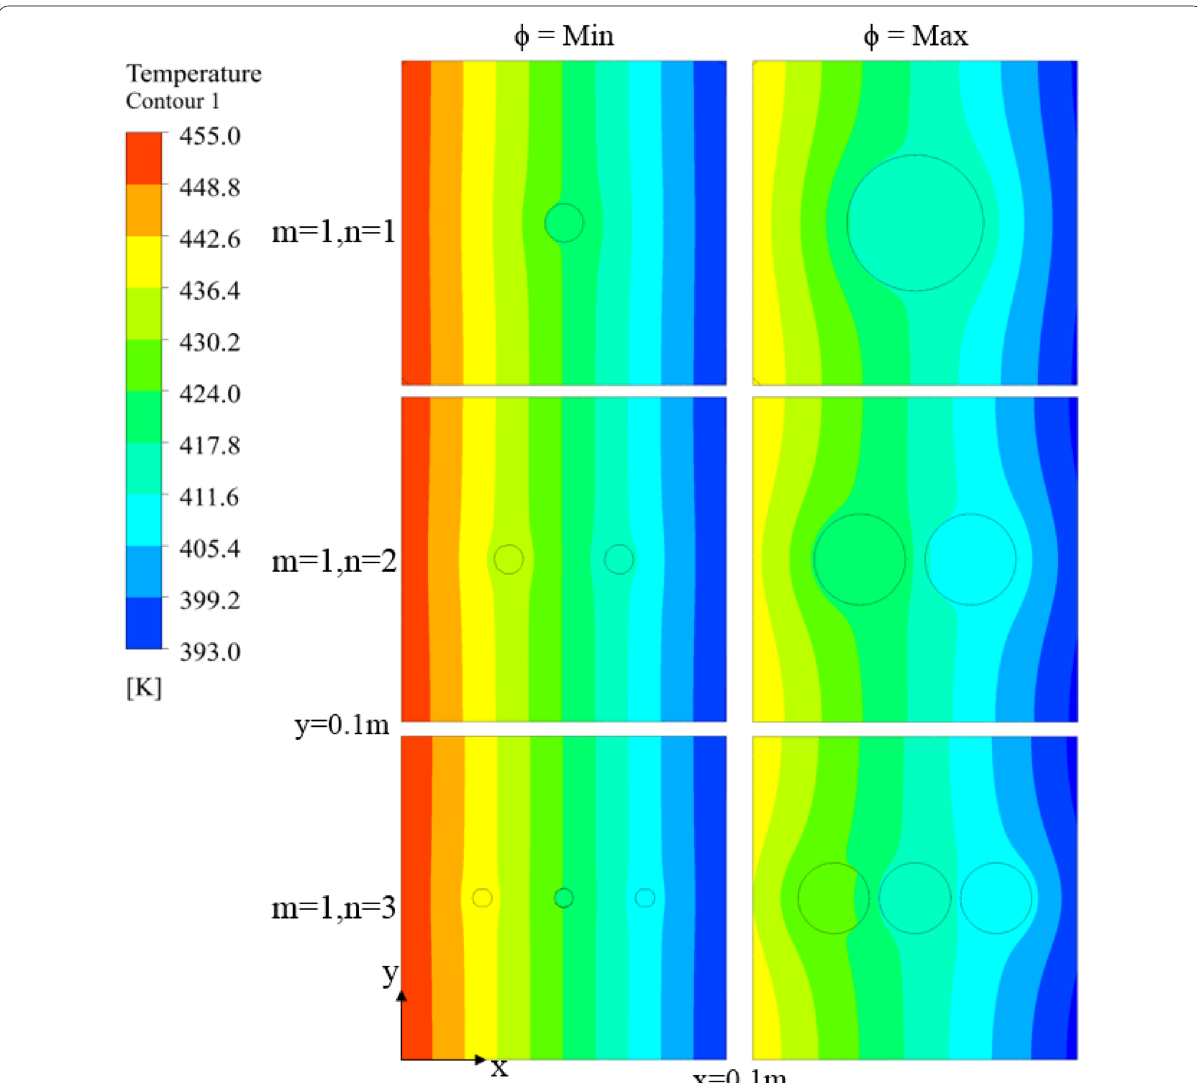
Fig. 8 Temperature distributions of reinforced concrete arranged in the heat transfer direction at the center cross sections of x–y plane in the volume fraction of minimum and